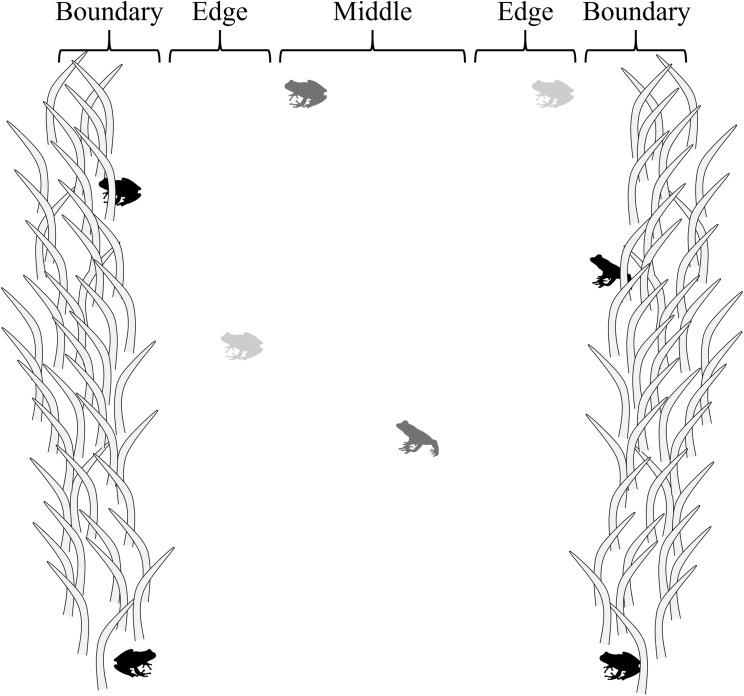
Transect sections used to evaluate how the risk response of frogs was influenced by proximity to cover.Middle sections were located ca. 25 cm from cover; edge sections were ca. 0–25 cm from cover; and boundary sections were adjacent to edge sections at the boundary of transects, ca. 25 cm into vegetation. In the figure, black frogs are in boundary sections, light gray frogs are in edge sections, and dark gray frogs are in the middle section.